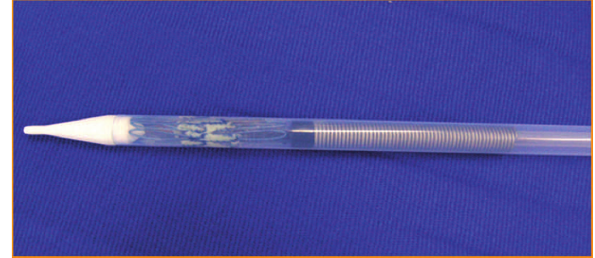
Fig. 3. Dispositivo (introdutor) contendo a prótese preparada para o implante